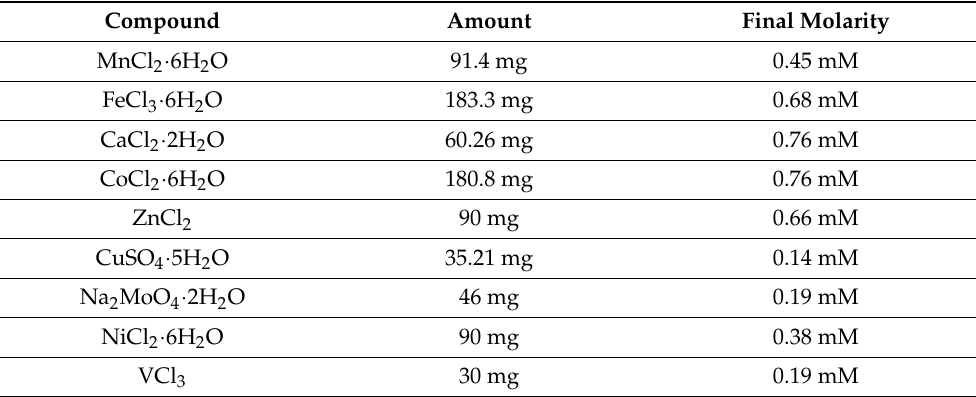
Table 2. Trace element